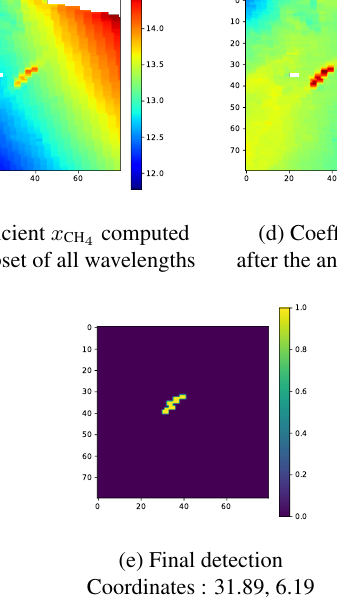
Figure 9. On all images, pixels in white are discarded pixels (cloudy for example). In (a), the L2 data with a methane plume in the middle of the image. In the other figures, the evolution of at each step of the the coefficient x CH 4